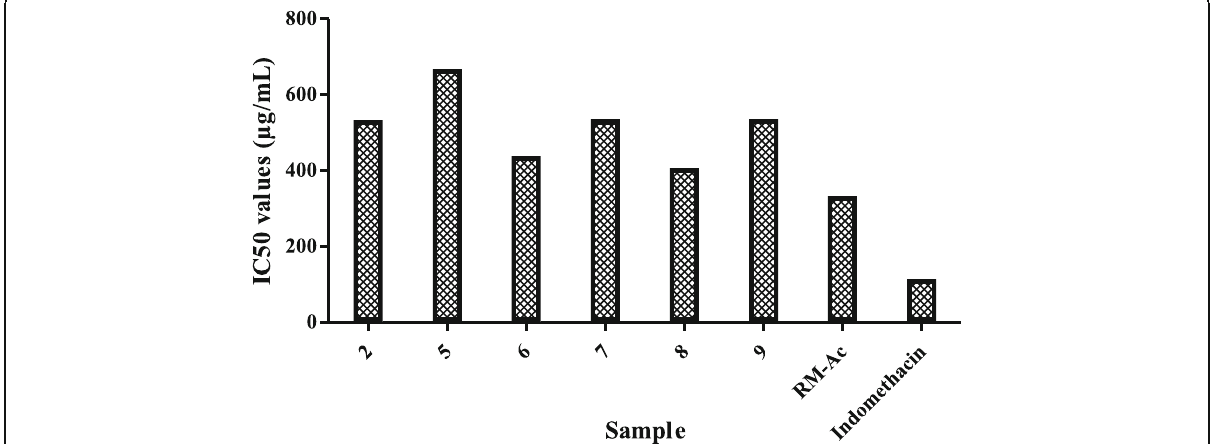
Fig. 3 IC 50 values of acetone extract and all compounds of Roccella montagnei against albumin protein